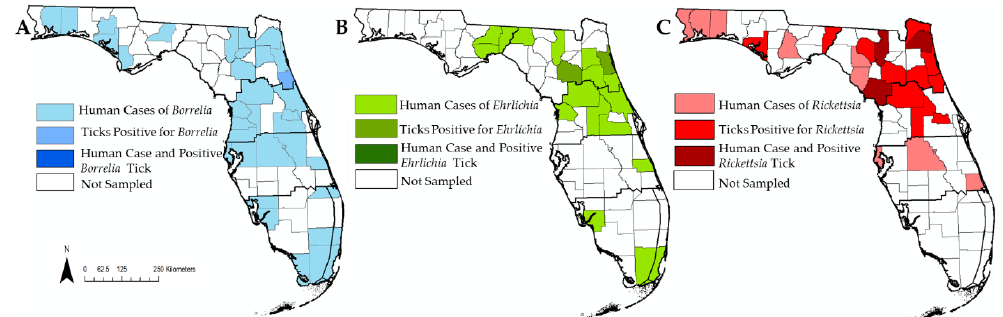
Figure 4. Maps of counties with reported human cases, tick detected with a pathogen and overlap between human cases and ticks infected with a pathogen. Thick black lines denote climatic regions. ( A ) Map of human cases of Lyme disease and detection of ticks with B. burgdorferi . ( B ) Map of human cases of Ehrlichiosis and detections of ticks infected with E. ewingii . ( C ) Map of human cases of Ehrlichiosis and detections of ticks infected with pathogenic Rickettsia species.